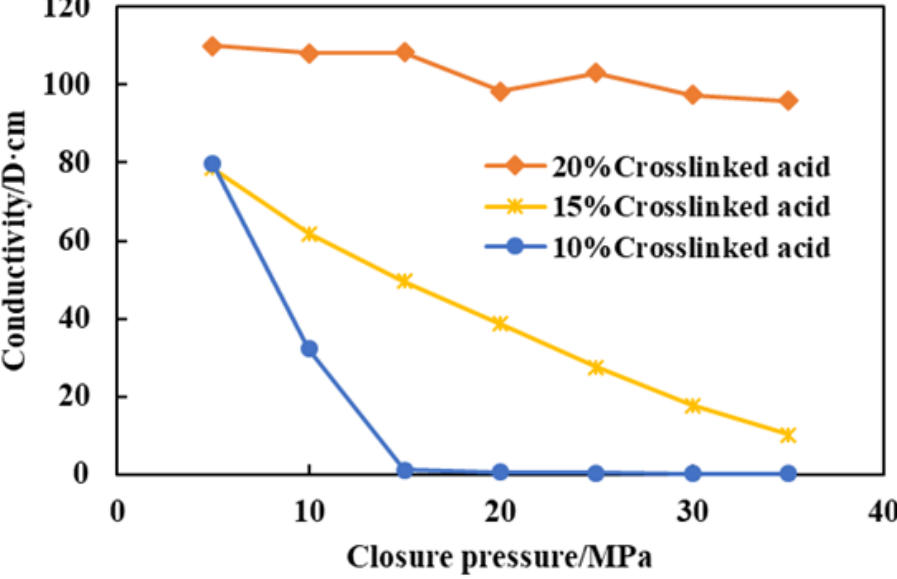
Figure 12. Variation of conductivity with closure pressure at different acid concentrations.